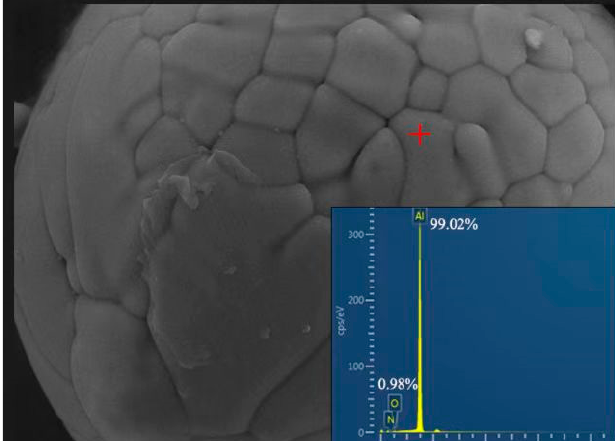
Figure 2. EDS analysis of Al-Li alloy microparticles.